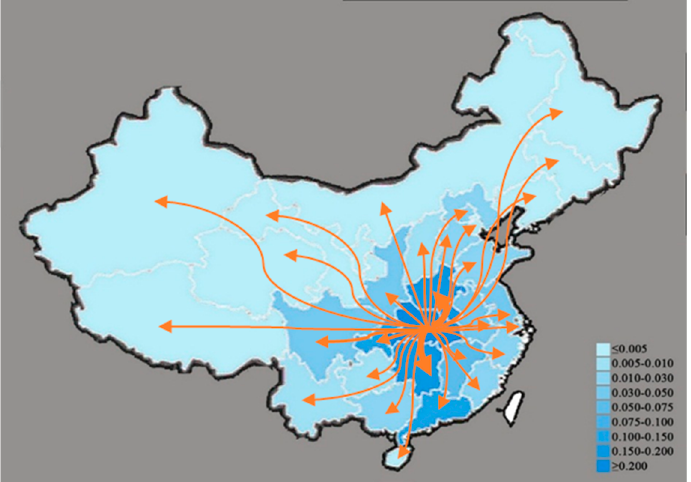
Figure 9. Heat map of population migration in China’s mainland from Hubei Province.